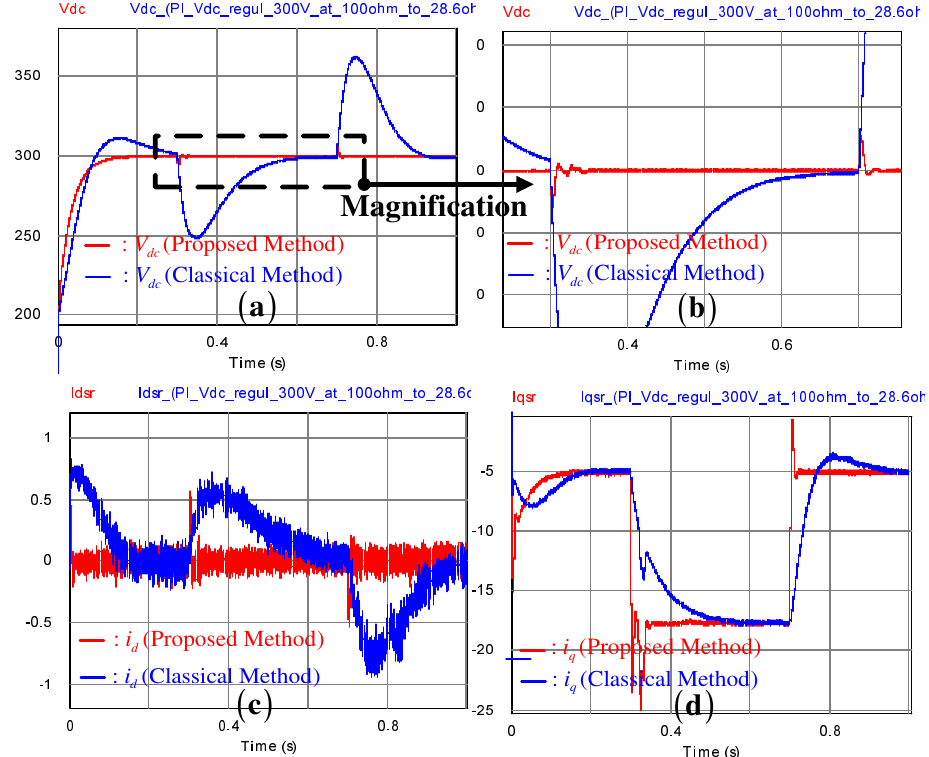
Figure 5. The comparison result of DC-link voltage regulation performance between the proposed method and the feedback linearizing (FL) method at the DC-link voltage of 300 V with a pulse resistive load torque from R L = 100 Ω to R L = 28.6 Ω ; ( a ) the resulting output voltage wave forms, ( b ) a magnified version of (a), ( c ) d -axis current wave forms, ( d ) q -axis current wave